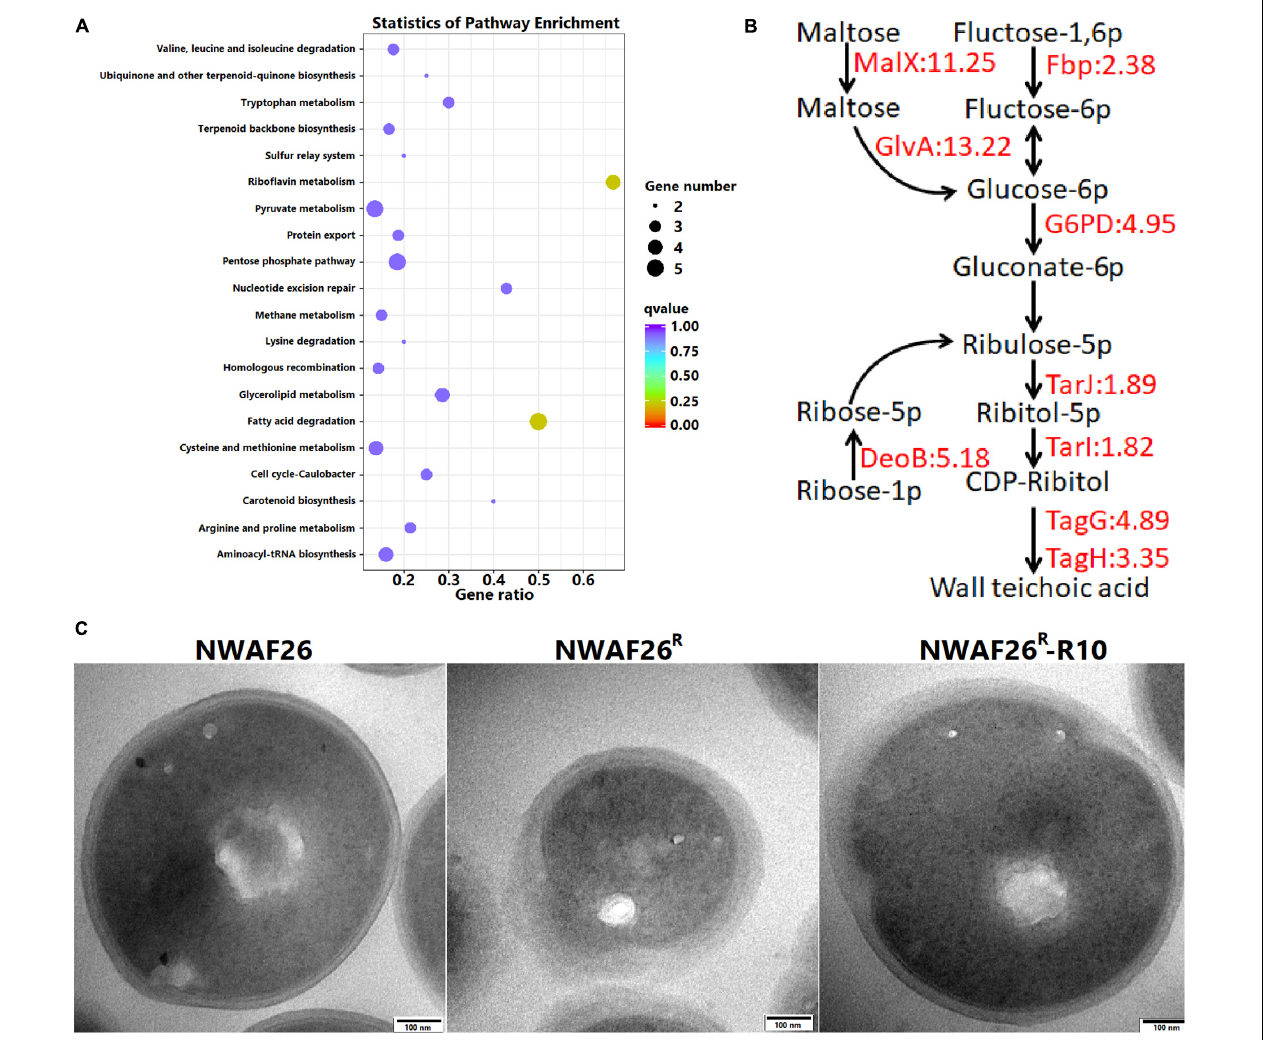
FIGURE 4 | The induced β -lactam resistance of S. sciuri caused by the thickened cell wall. (A) KEGG enrichment scatter map of the upregulated differentially expressed gene in NWAF26 R compared with NWAF26. (B) The expression of genes related to wall teichoic acid (WTA) synthesis pathway was upregulated in NWAF26 R and highlighted with red color, the number represented the fold changes of upregulation. (C) Transmission electron microscopy (TEM) analysis of NWAF26 and its derivations at the stationary phase. NWAF26 R -R10 represents the 10th generation isolate induced from NWAF26 R without oxacillin. The standard ruler is 100